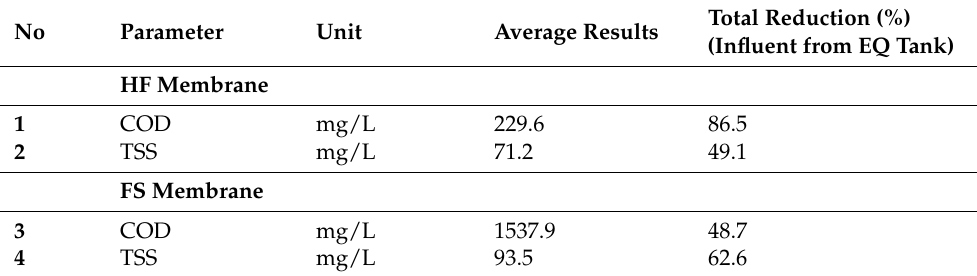
Table 5. Characteristics of effluent in a DAF system.